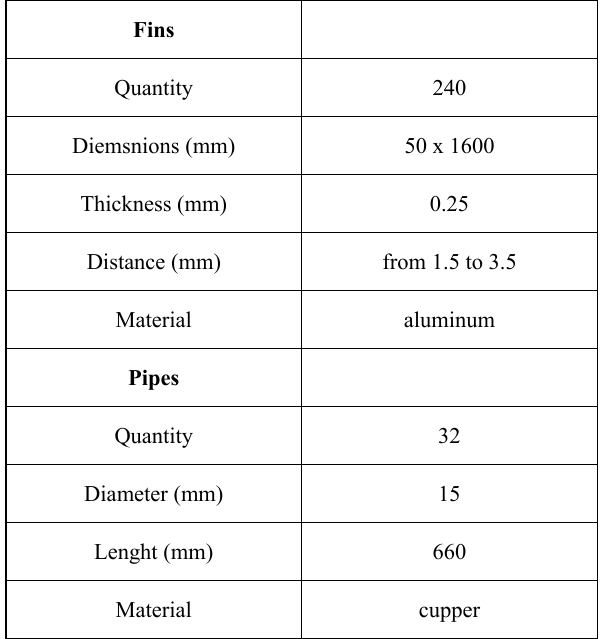
Fig. 2. Heat exchanger (detail). Table 1. Dimensions of exchanger.